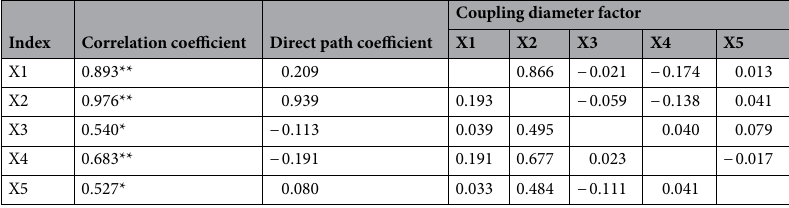
Table 4. Path analysis of grain filling characteristic parameters. X1 stands for Tmax, X2 stands for Wmax, X3 stands for Rmax, X4 stands for P, X5 stands for Gmean, and Y stands for 100-grain weight. Tmax is the time when the maximum grouting rate was reached; Wmax is the grain growth at the maximum filling rate; Rmax is the maximum grouting rate; P is the active grouting stage; Gmean is the average grouting rate; A is the ultimate growth rate of the